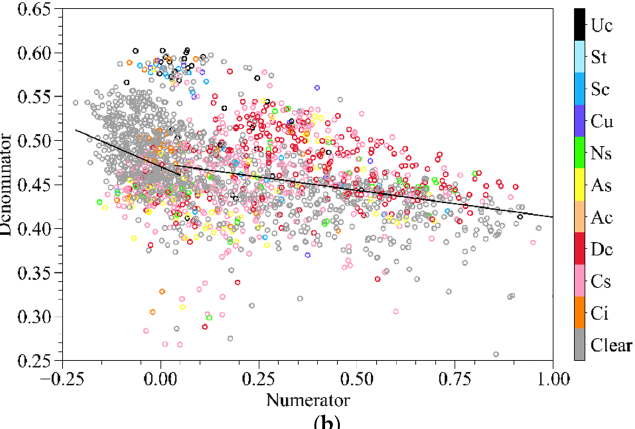
Figure 5. Scatterplots of the numerator (horizontal axis) and denominator (vertical axis) of the AMSU-A cloud index from NOAA-19 over East Asia at ( a ) 0600 UTC 26 June and ( b ) 0600 UTC 28 June 2019, where the colors represent the matched MODIS cloud classification products. The solid black line on the left in ( a , b ) is the fitted line for observations with the A index less than 0.1, and the solid black line on the right is the fitted line for the remaining observations.